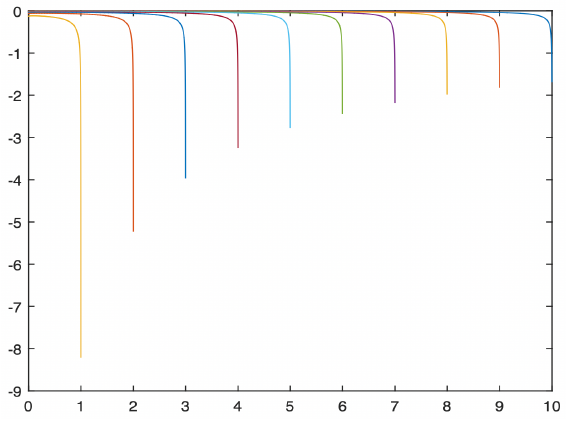
Figure 1. the solutions of ˙ g ( s , t ) for t = 1,2,3, · · · ,10 when H =